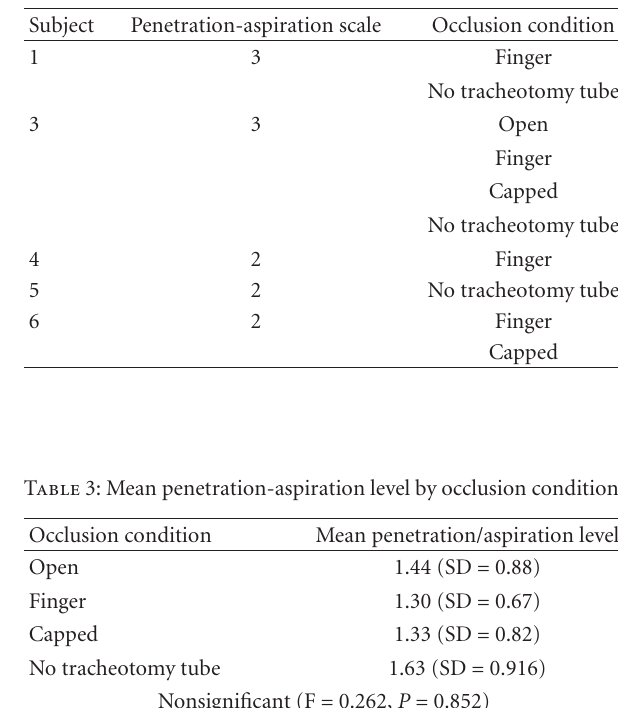
Table 2: Penetration/aspiration.